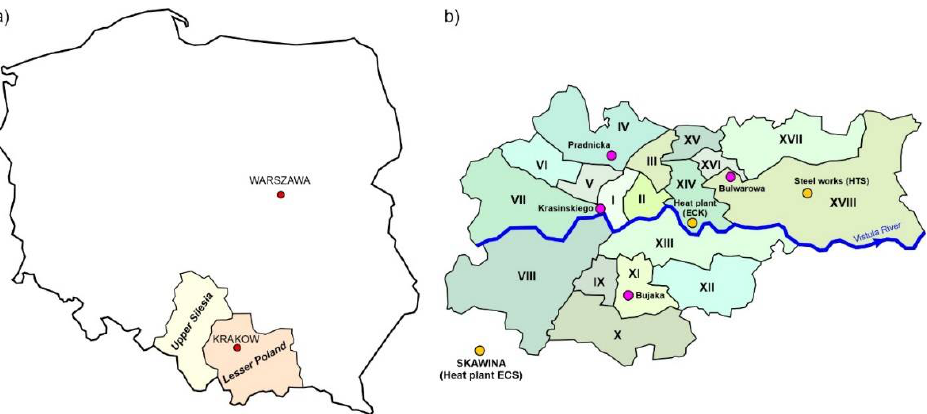
Figure 1. ( a ) The map of Poland with the location of Krakow, Warsaw and two regions: Lesser Poland and Upper Silesia. ( b ) Krakow boroughs and the location of the places mentioned in the text: HTS—Sendzimir Steelworks, ECK—Heat and Power Plant Krakow, ECS—Heat and Power Plant Skawina, and measuring stations: Pradnicka St., Bujaka St., Krasinskiego Av., Bulwarowa St.